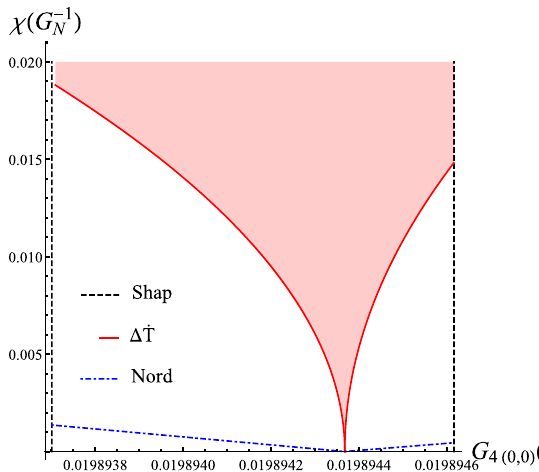
Fig. 1 The allowed parameter spaces ( G 4 ( 0 , 0 ) ,χ) set by the Nordtvedt effect (the region above the dot dashed blue curve), the Shapiro time delay (the region enclosed by the two vertical, dashed black lines) and the observation of the binary pulsar PSR J1738+0333 (the region above the solid red curve, labeled by (cid:18) ˙ T ), respectively. The shaded area is the commonly allowed parameter space. The horizontal and the vertical axes are both measured in units of G − 1